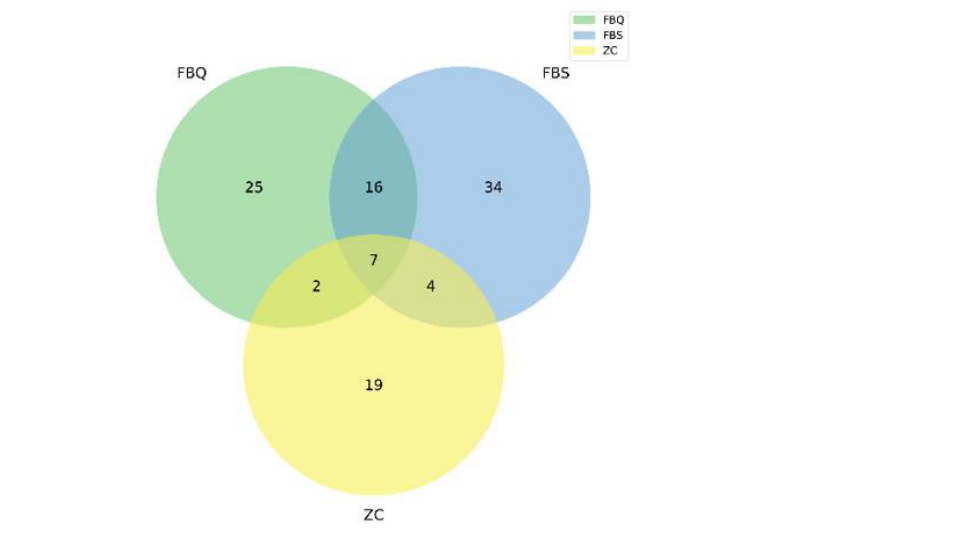
Figure 3. Venn diagram of fungal diversity of Mianning hams. The figures in different compartments mean the numbers of fungal specific for or common to Mianning ham of different qualities.